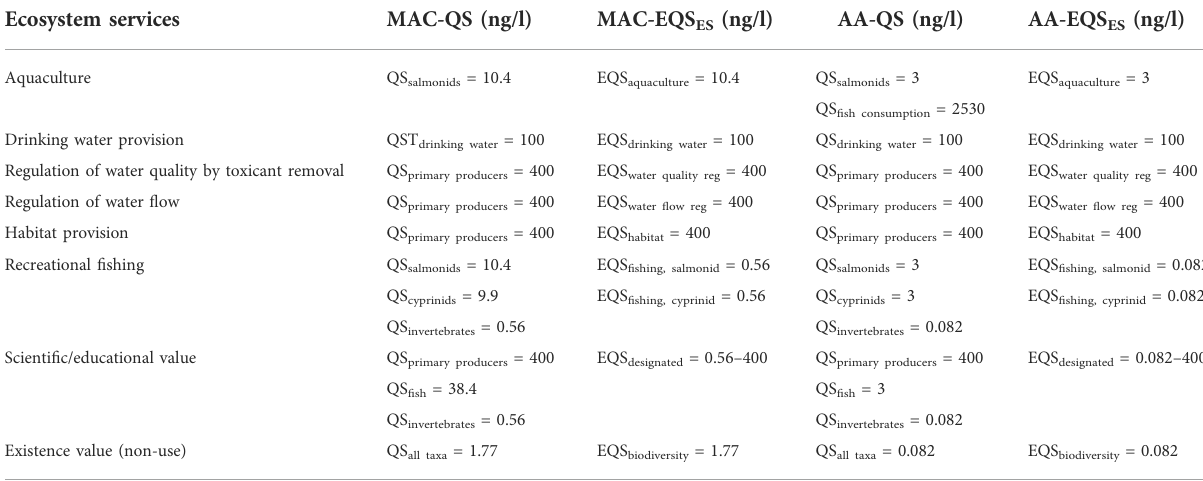
TABLE 5 Service provider quality standards (QS) and ecosystem services-speci fi c EQS values for a pyrethroid insecticide. Maximum acceptable concentration (MAC) standards are based on acute data and annual average (AA) standards are based on chronic data. Ecosystem services